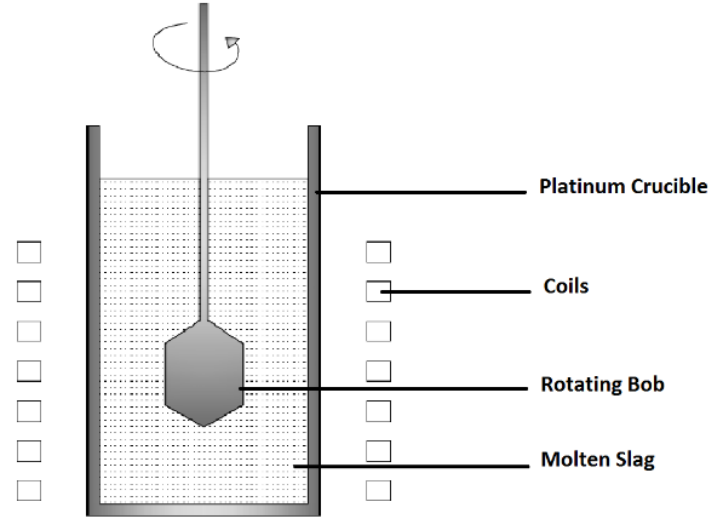
Figure 5. Schematic diagram of the experimental set-up for the rotational viscometer test.